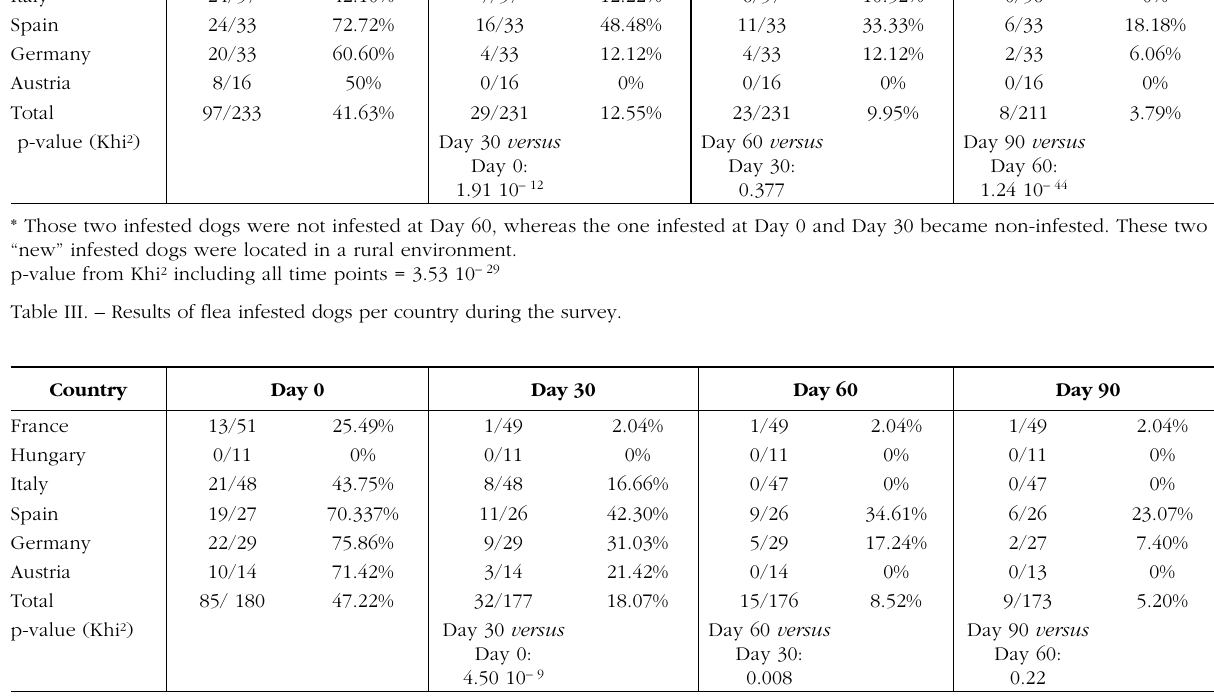
Table IV. – Results of flea infested cats per country during the